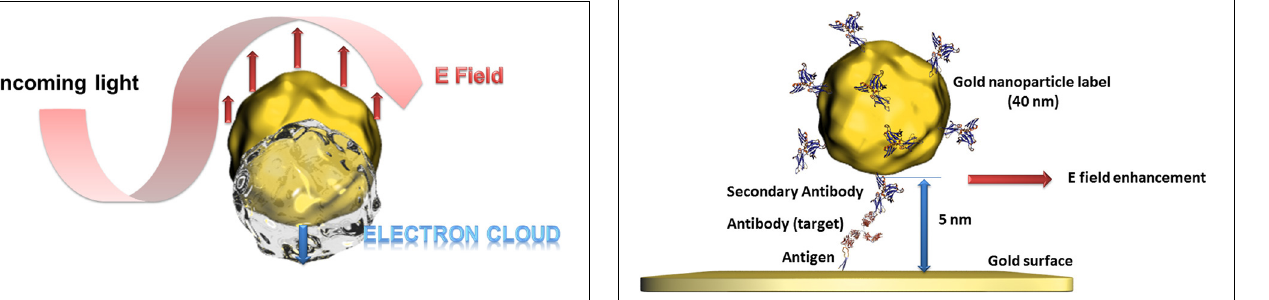
FIGURE 2 | Illustration of the perturbation of propagating surface plasmons on gold surfaces provoked by gold nanoparticles of defined size and distance leading to an additional change of the evanescent field and therefore to an enhanced